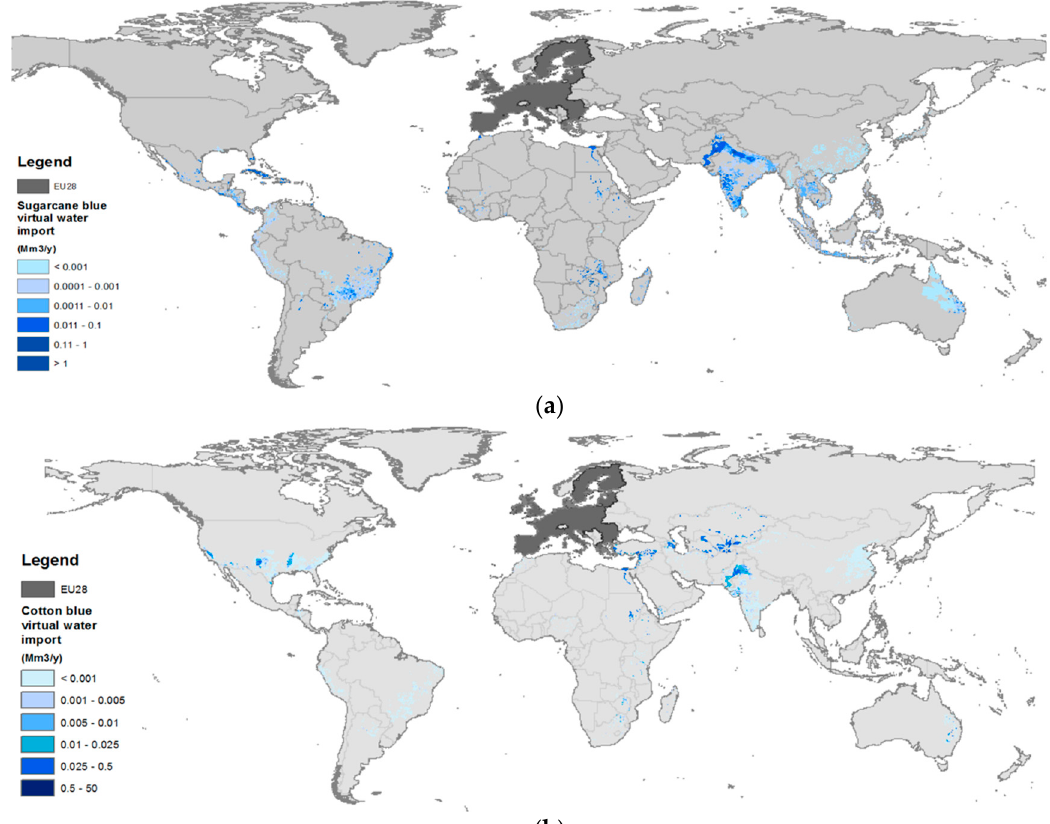
Figure 6. Green virtual water imports to the EU per grid cell related to coffee ( a ), oil palm ( b ), cocoa ( c ) and soybean ( d ) (million m 3